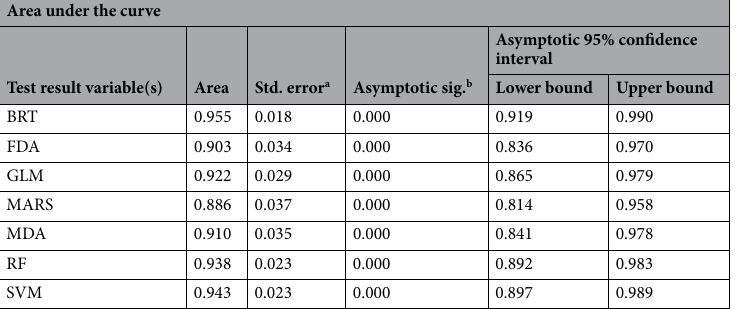
Table 8. Predictive performance of the seven applied models in the validation process of landslides 2021. The test result variable(s): MARS has at least one tie between the positive actual state group and the negative actual state group. Statistics may be biased. a Under the nonparametric assumption. b Null hypothesis: true area = 0.5.